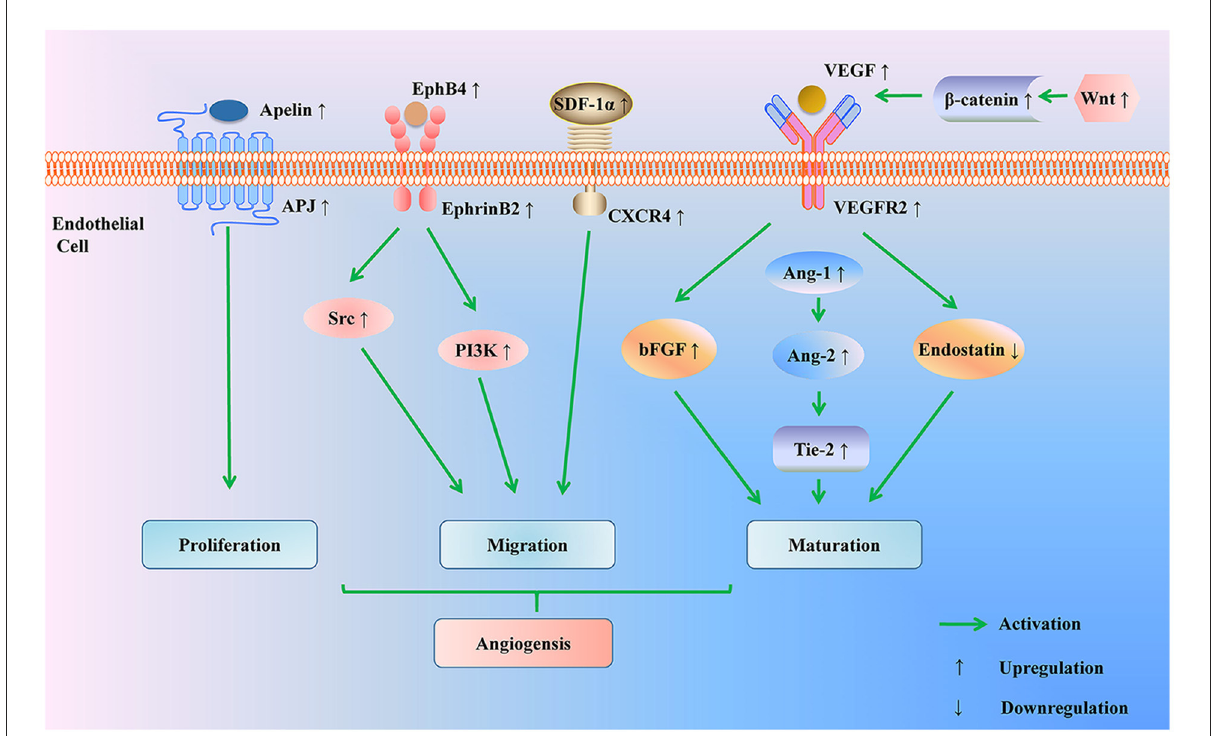
FIGURE3 Regulation of angiogenesis pathway by acupuncture for treating ischemic stroke. Acupuncture promotes angiogenesis through multiple pathways: acupuncture up-regulates Apelin-APJ system to induce endothelial cells proliferation; acupuncture promotes endothelial cells migration by modulating the EphB4/EphrinB2 signaling pathway and SDF-1/CXCD4 axis; acupuncture activates the Wnt/ β -catenin signaling pathway to elevate the expressions of angiogenic factors (VEGF, bFGF, Ang-1, Ang-2, and Tie-2) and to reduce the level of anti-angiogenic factor (endostatin). PI3K, phosphoinositide 3 kinase; SDF-1 α , stromal cell-derived factor-1 α ; CXCR4, CXC chemokine receptor 4; VEGF, vascular endothelial growth factor; VEGFR2, VEGF receptor-2; bFGF, basic fibroblast growth factor; Ang-1, Angiopoietin-1; Ang-2, Angiopoietin-2; tyrosine kinase receptor 2